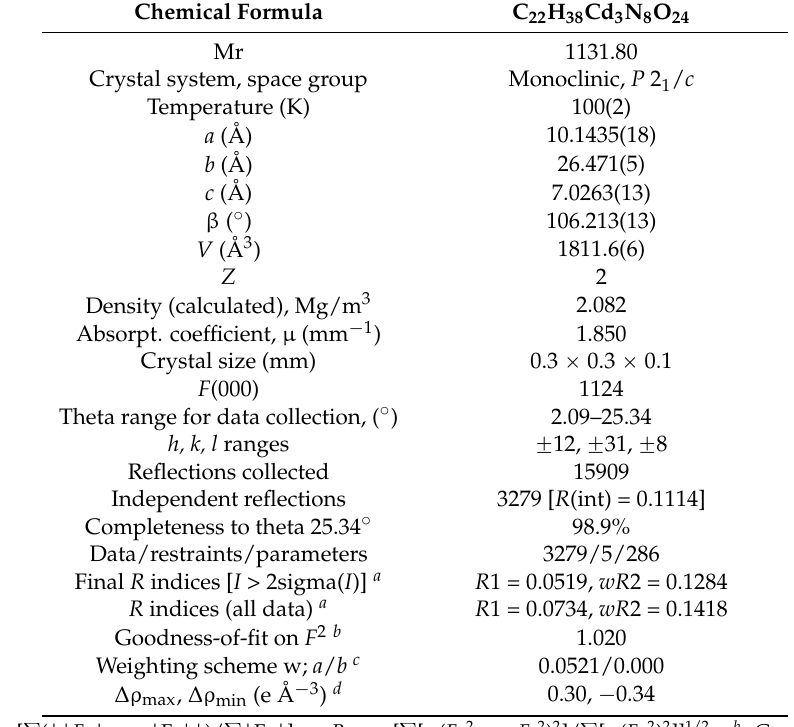
Table 3. Crystal data and refinement details for 1-D {[Cd(H 2 O) 6 ][Cd 2 (atr) 2 ( µ 2 -btc) 2 (H 2 O) 4 ] 2H 2 O} n , 1